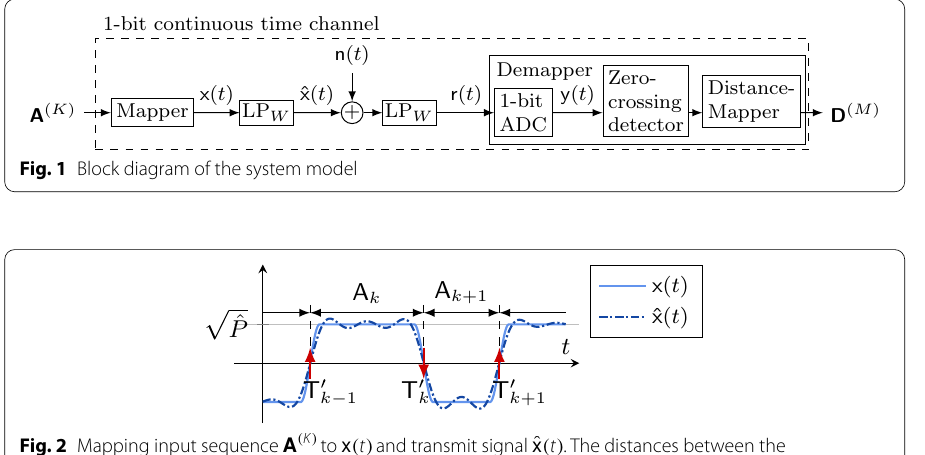
Fig. 2 Mapping input sequence A ( K ) to x ( t ) and transmit signal zero-crossings correspond to the sequence A ( K ) and the impact of LP-filtering on the transition slope and the x ( t signal level is seen in ˆ